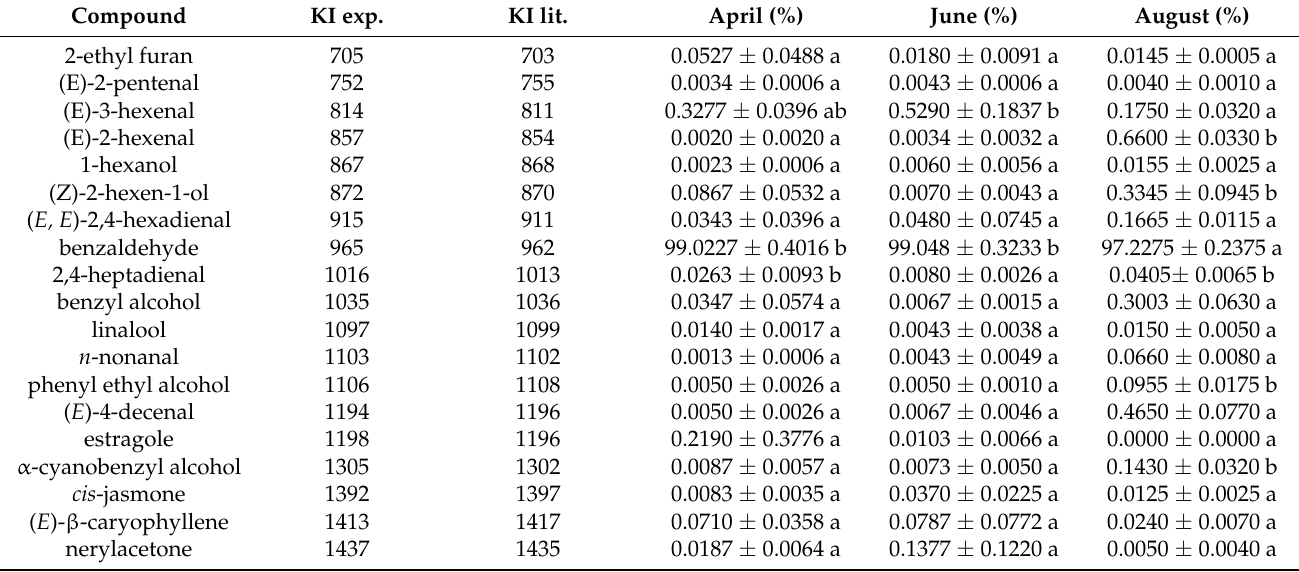
Table 2. Composition of volatile organic compounds (%) identified in fresh Prunus serotina leaves collected in three months of growing season (April, June and August). Data are mean ± SD. KI exp.—retention index calculated according to n-alkanes; KI lit.—retention index obtained from NIST17 and Adams [29] database. Significant differences between months marked in rows by different letters (a, b) were estimated by HSD of the Tukey test or Kruskal–Wallis test, p ≤ 0.05; n = 3. Compound KI